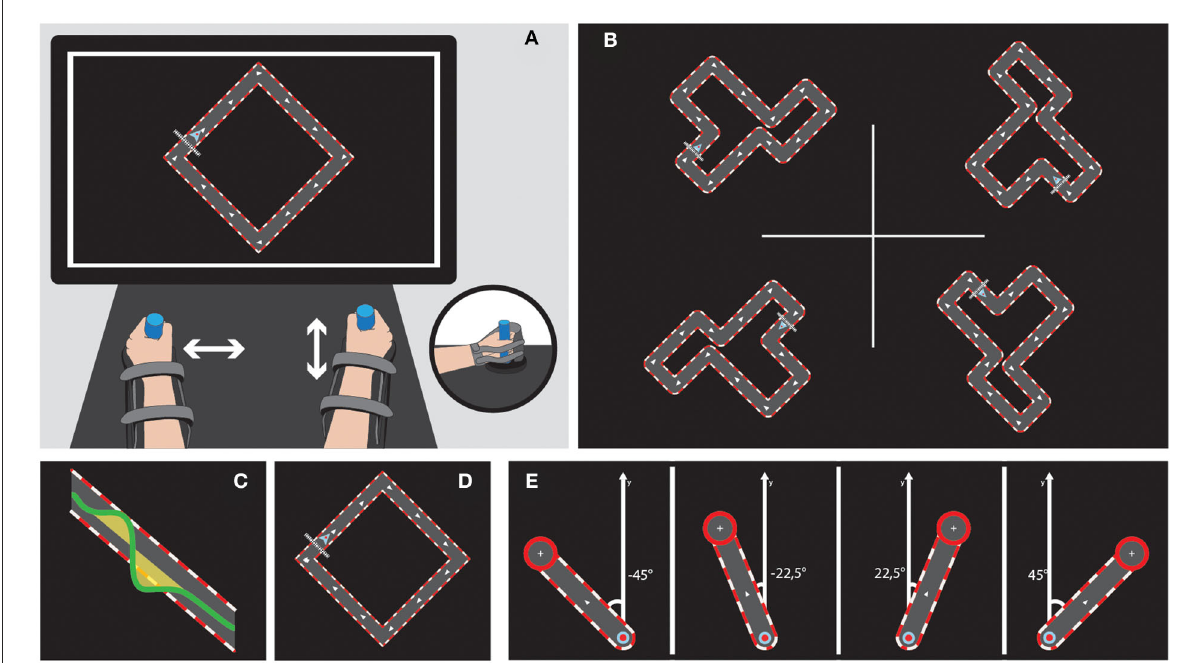
FIGURE2 Bimanual tasks on the REAplan ® . Upper left (A) General setup of the bimanual version of the REAplan ® robot. Note that each hand slides exclusively along one axis and thus controls a different direction of the common cursor (small arrowhead) displayed on the REAplan ® screen. The forearms rested in gutters and were strapped. Handles were adapted, if needed. Upper right (B) Four different circuits of identical length and difficulty. Bottom, from left to right: Cursor’s displacement with regard to the ideal trajectory defined as the center of the circuit’s track (surface = error) (C) , simple square used for familiarization (D) , and REACHING toward the four targets (E) .